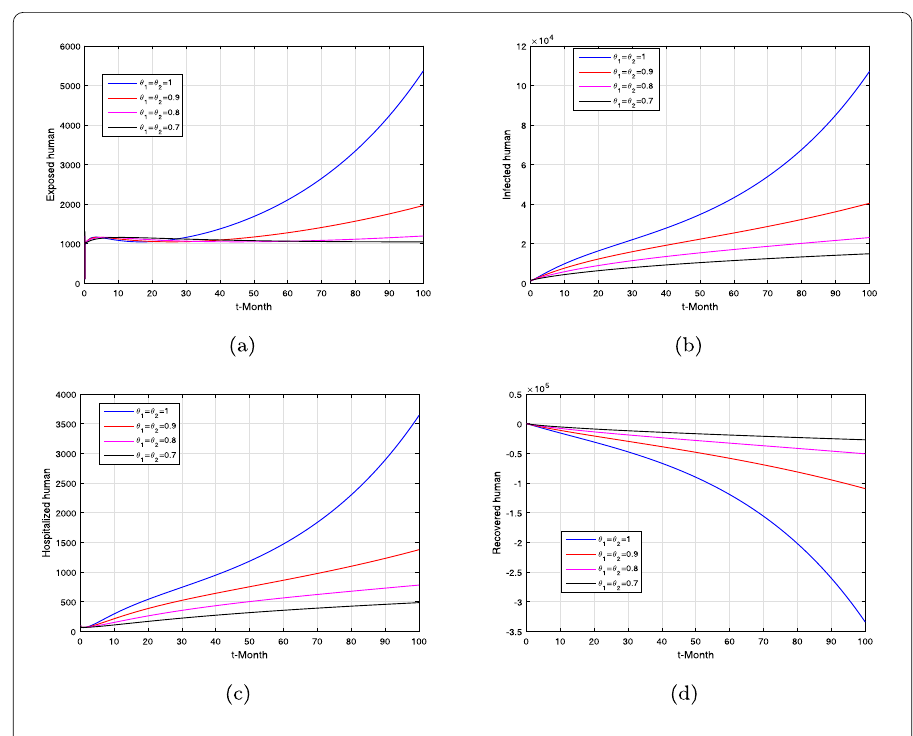
Figure 7 Simulation of the fractal-fractional model (10) when θ 1 = θ 2 = 1,0.9,0.8,0.7 where ( a ) exposed humans, ( b ) infected humans, ( c ) hospitalized humans, ( d ) recovered humans